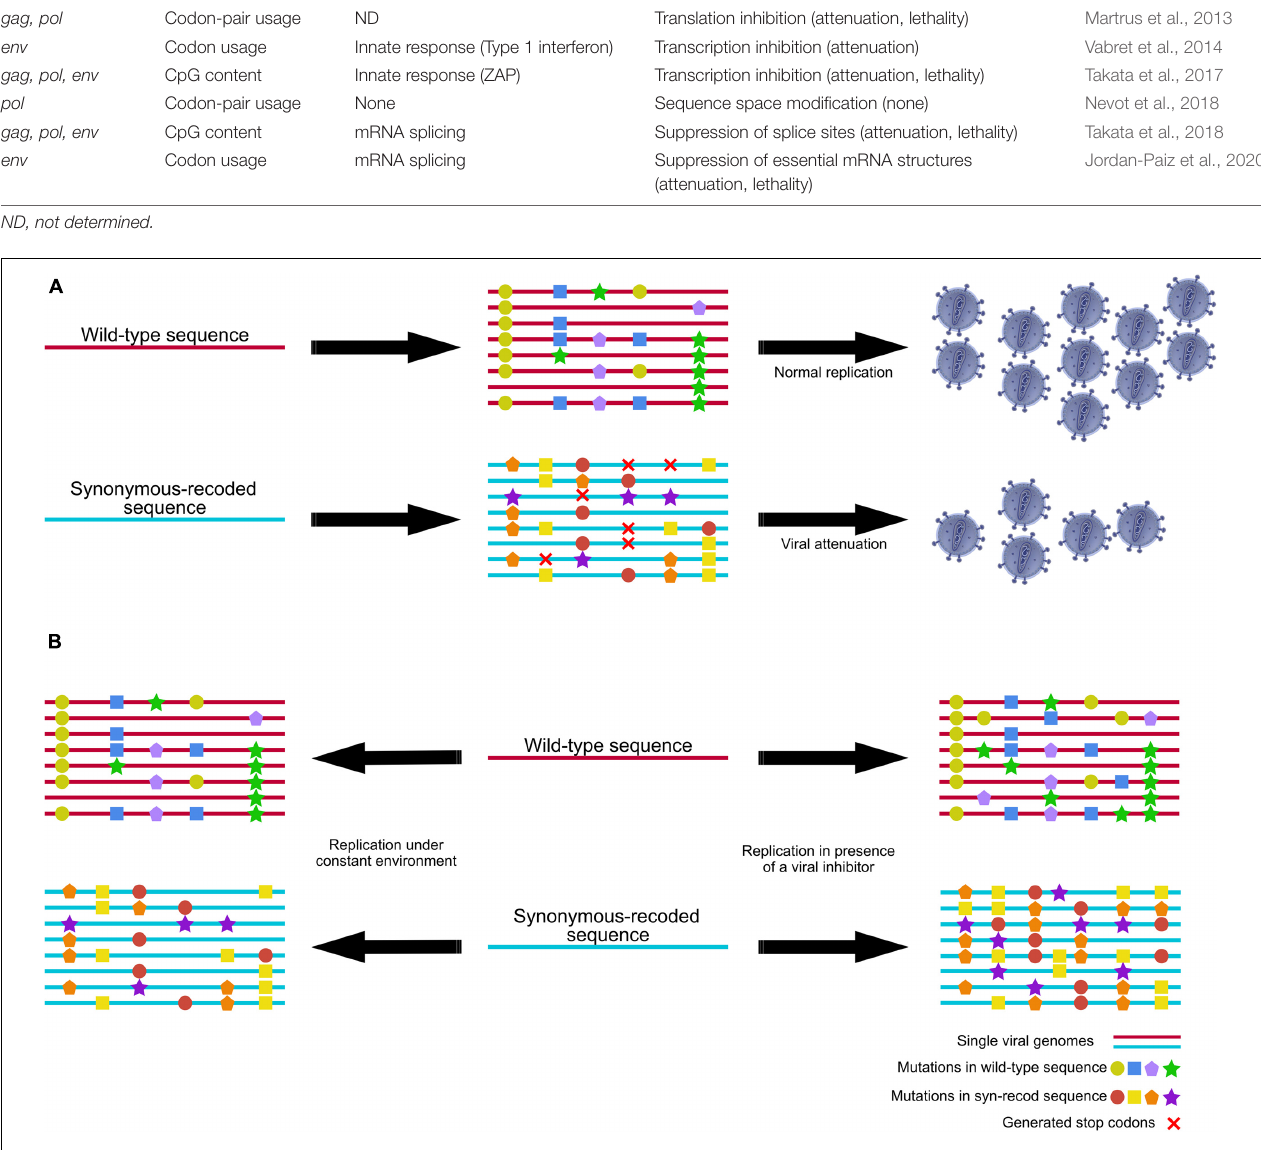
FIGURE 3 | Viral population diversity and evolvability of a wild-type sequence and a synonymously recoded sequence. (A) Synonymous recodification of a viral sequence leads to a different and limited mutant spectra which may result in the generation of stop codons. The generation of stop codons in the mutant spectra results in virus attenuation (Lauring et al., 2012; Moratorio et al., 2017). (B) Replication of a wild-type (WT) virus and a synonymous-recoded virus under a constant environment may lead to different mutant spectra, but not necessarily to generation of stop codons or viral attenuation. Under the presence of a viral inhibitor, the number of mutations found in the synonymous-recoded virus is higher than those generated in the WT virus. Moreover, these mutations differ from both viral mutant spectra, indicating that the sequence space influences the development of inhibitor resistances (Nevot et al., 2018).